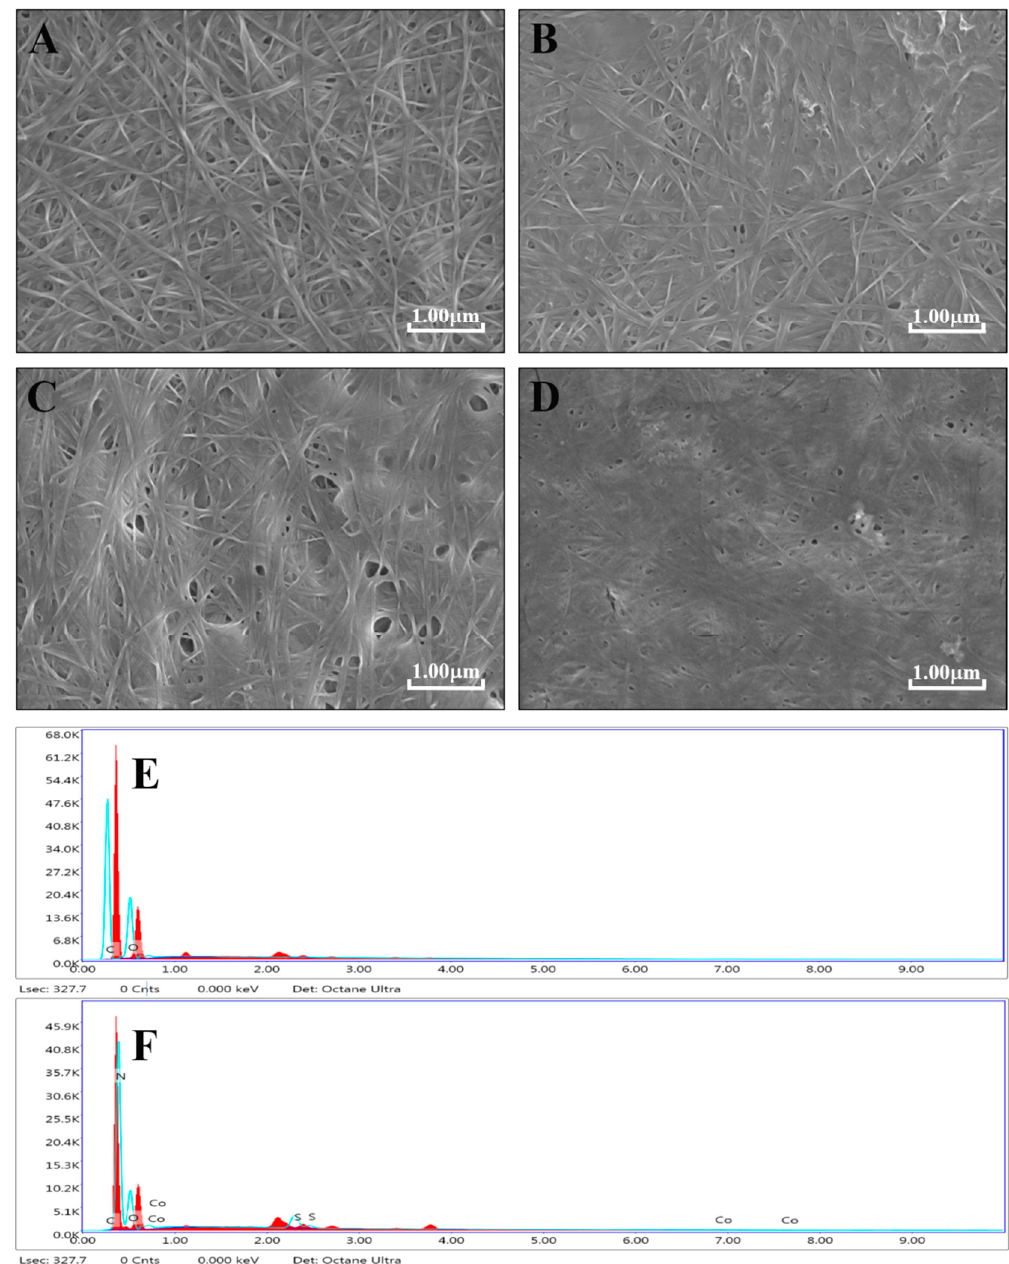
Figure 1. FESEM of ( A ): BC; ( B ): GOBC; ( C) : rGBC; and ( D ): Pc-rGBC. EDX spectra of ( E ): rGBC; ( F ): Pc-rGBC.